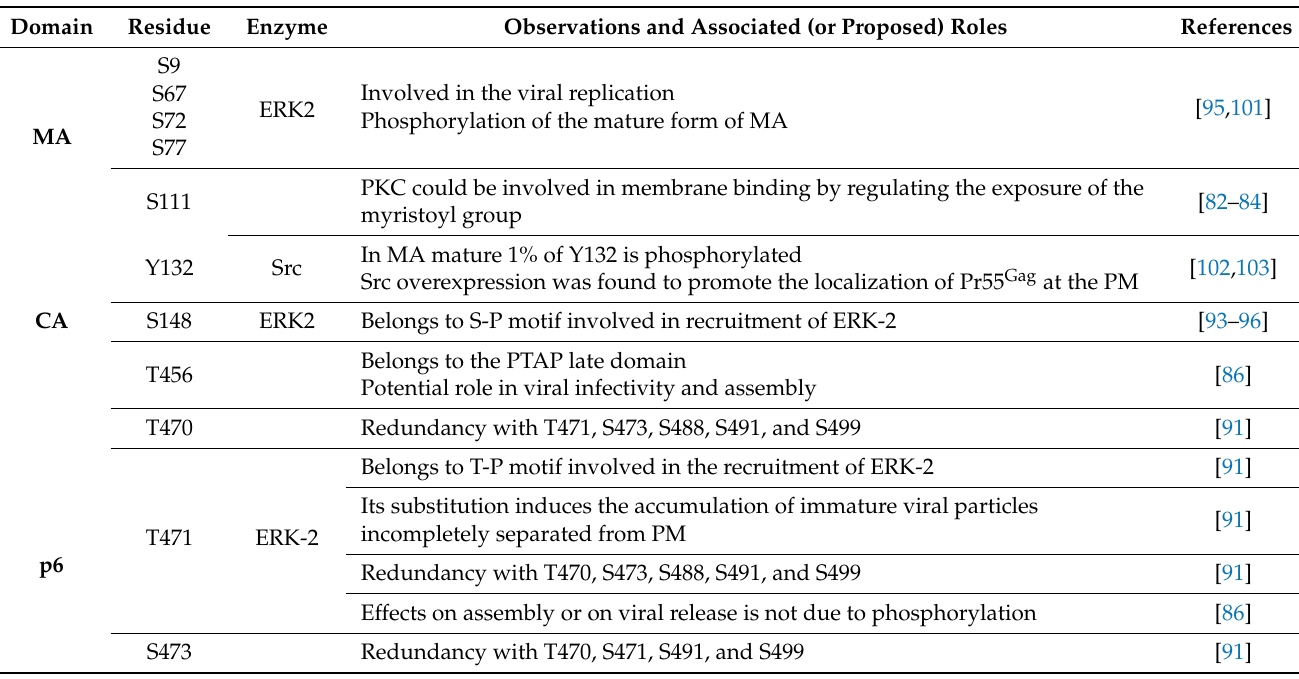
Table 1. Summary of different roles of phosphorylated residues in HIV-1 Pr55 Gag